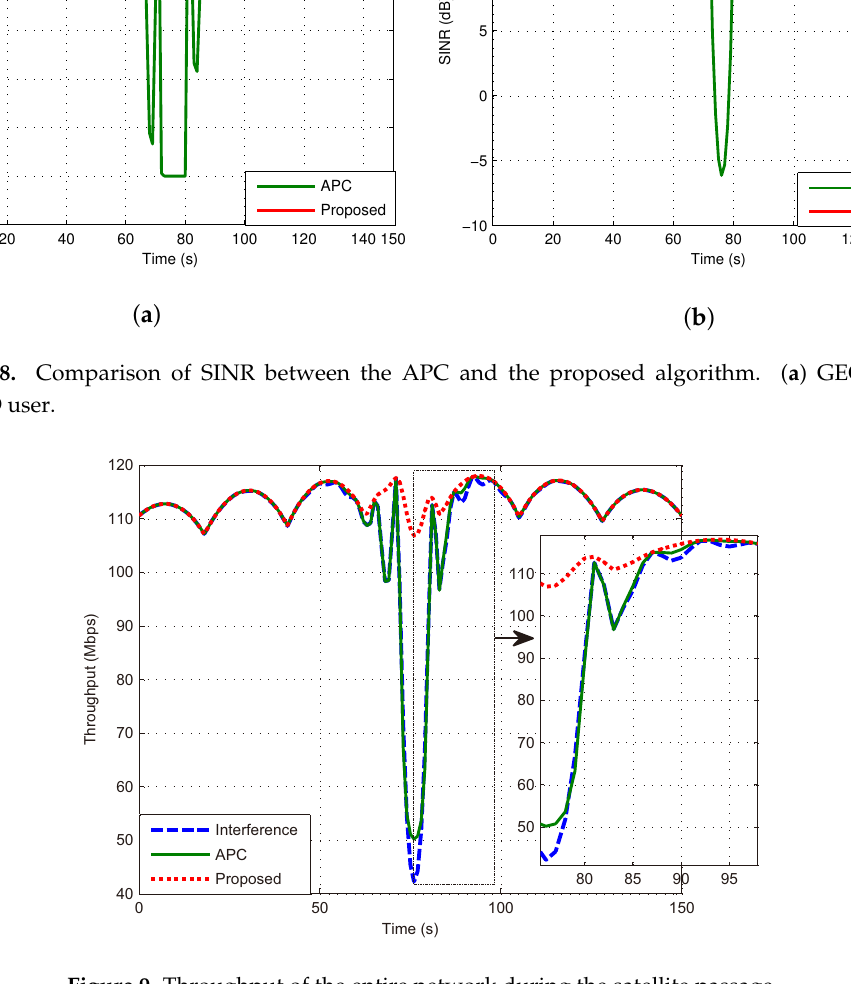
Figure 9. Throughput of the entire network during the satellite